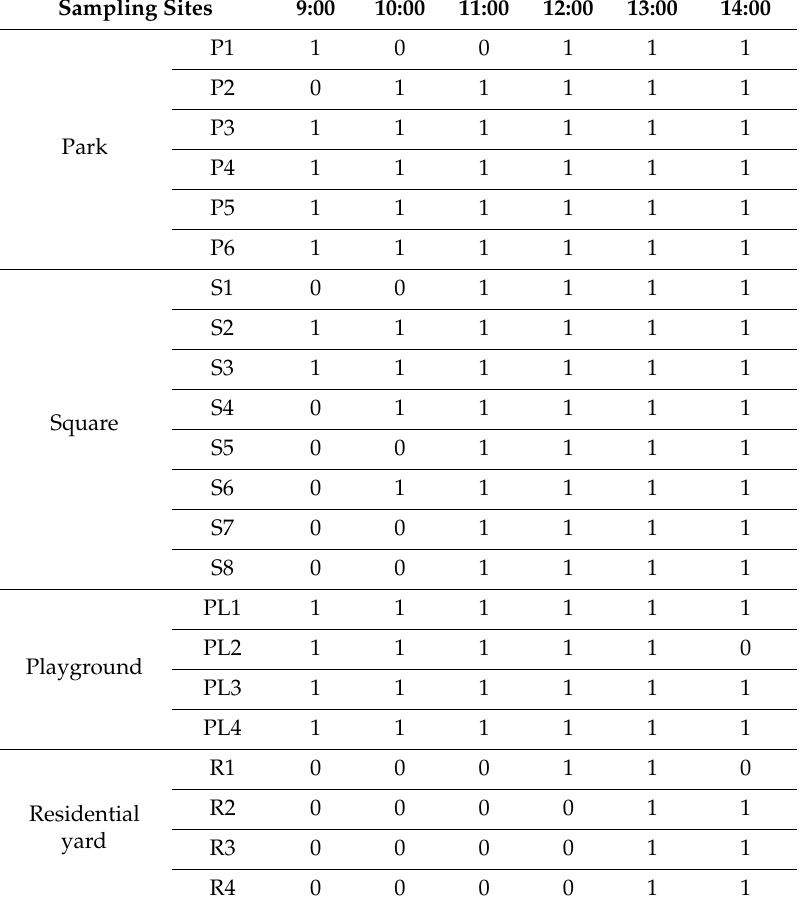
Table 10. The sunlight conditions of the observation sampling sites during the peak period. Sampling Sites